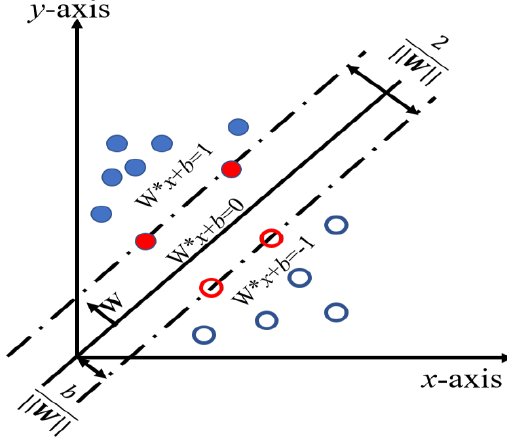
Figure 9. SVM schematic. The blue circles in Figure 9 represent data points. Solid circles are classified as one type of data and hollow ones as another. The red circle is used as an important sample for